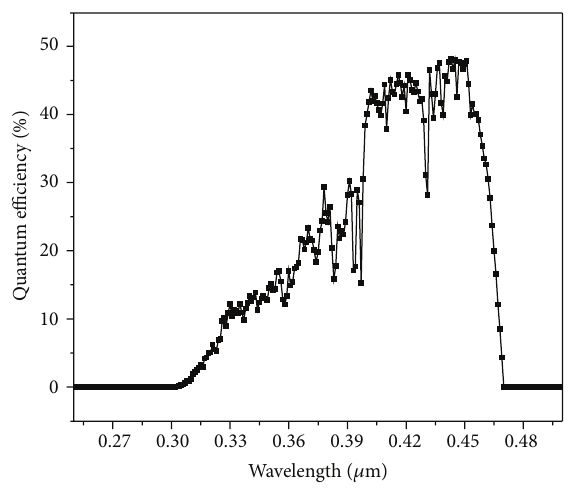
Figure 4: Quantum efficiency of optimized p-i-n GaN/InGaN double heterojunction solar cell.